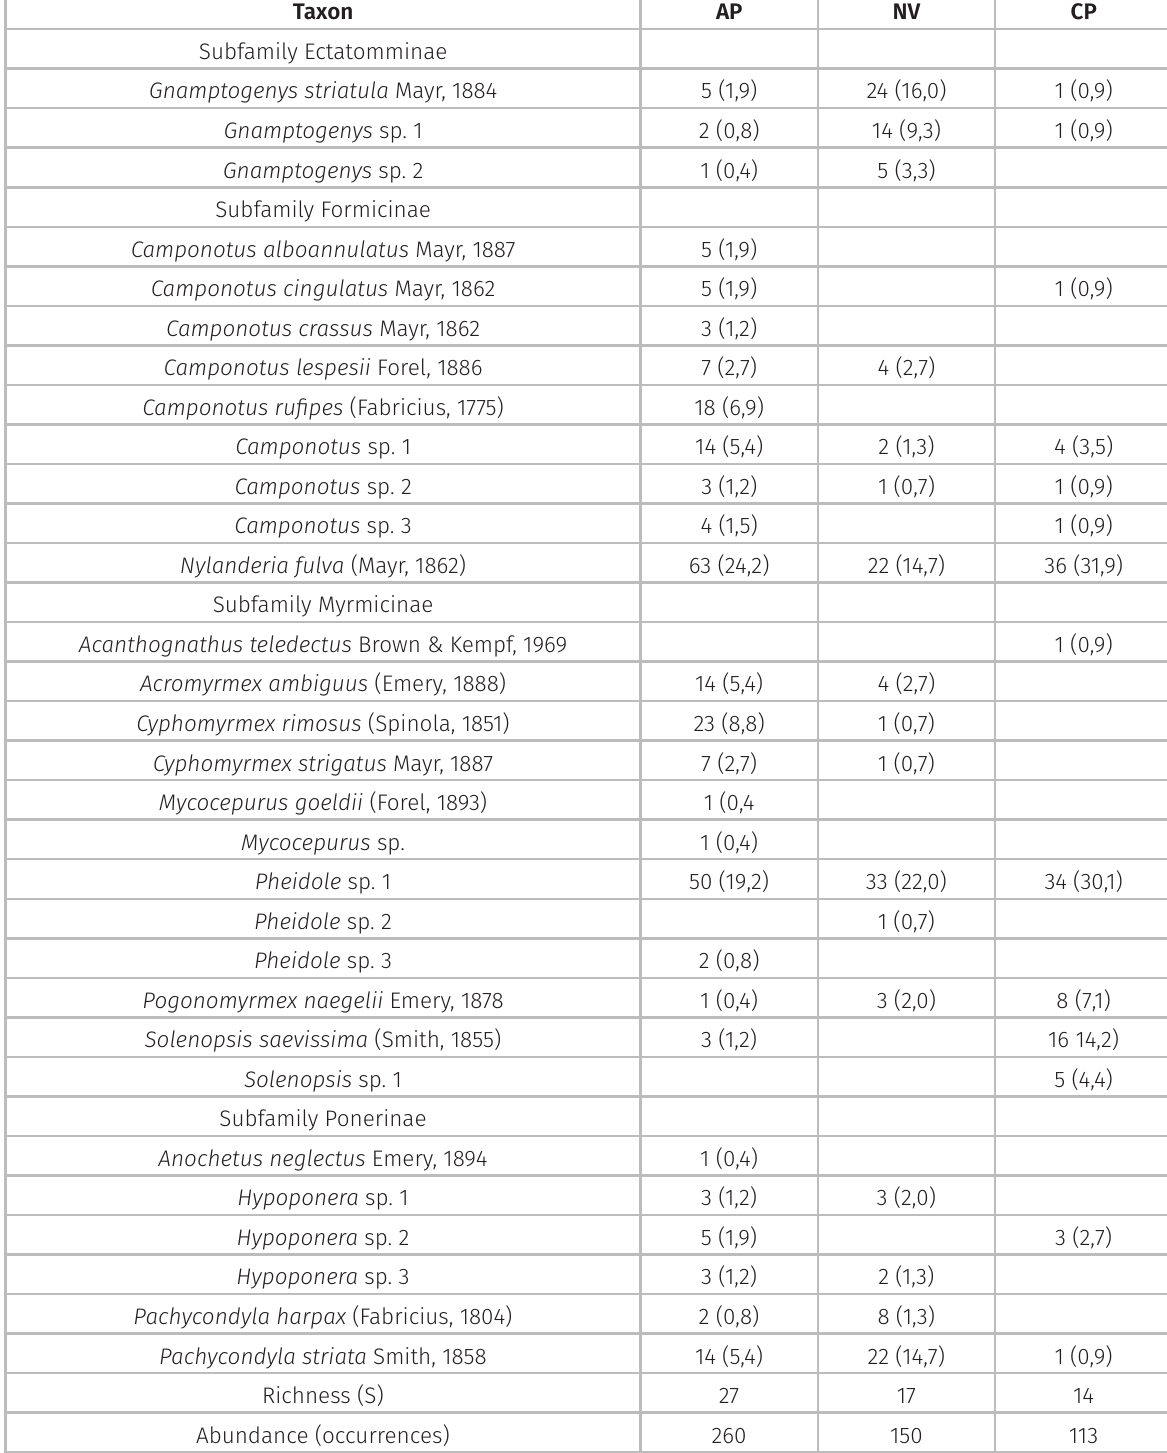
Table I. Species, occurrences and relative frequency (%) in agroecological peach orchard, conventional peach orchard and native vegetation in Colônia São Manoel, Pelotas, RS, Brazil, 2017 and